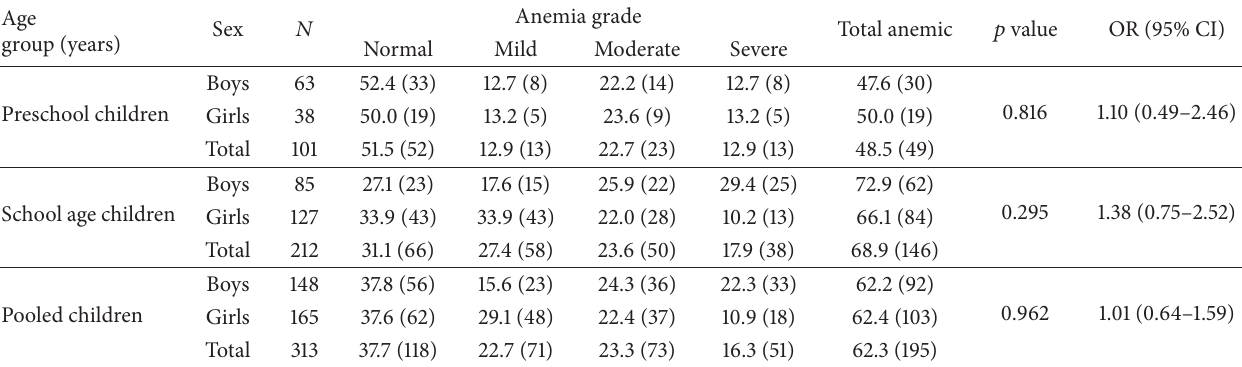
Table 4: Prevalence (%) of anemia by hemoglobin (g/dL) among children in Odisha. Age group (years)